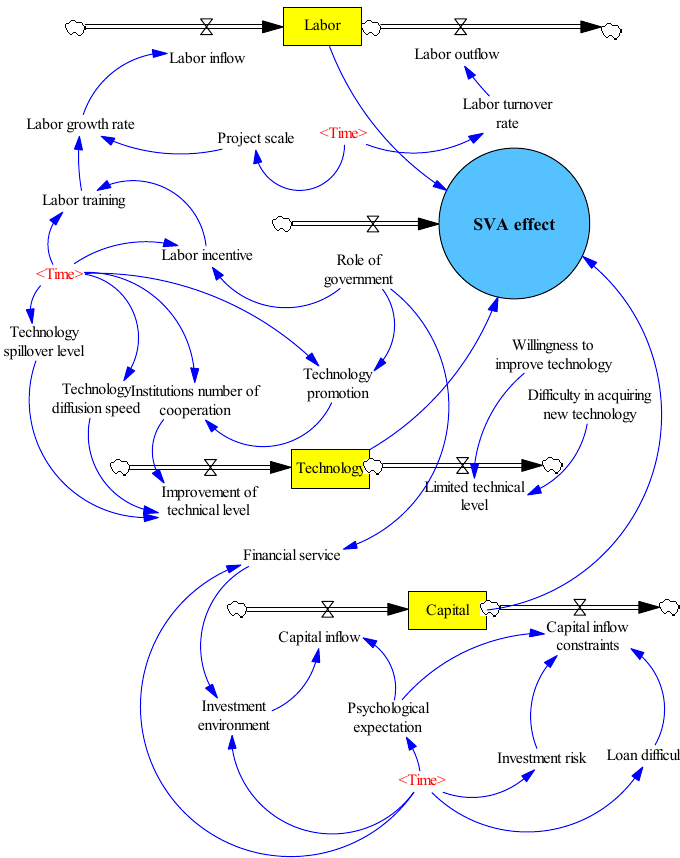
Figure 5. Specialized villages agglomeration system. Arrows indicate causality; <time> is a hidden variable.